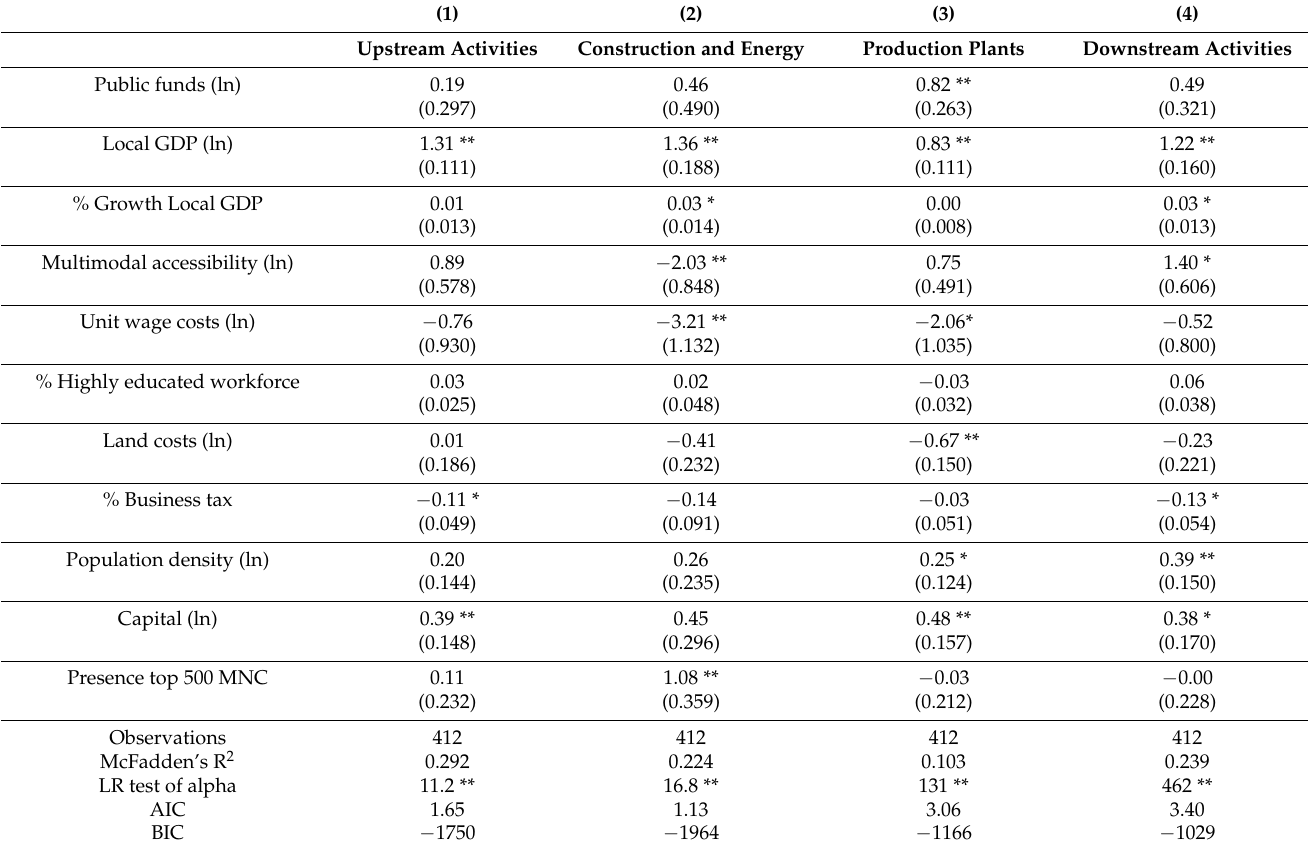
Table 6. Negative Binomial Estimations on Number of Greenfield FDI by Economic